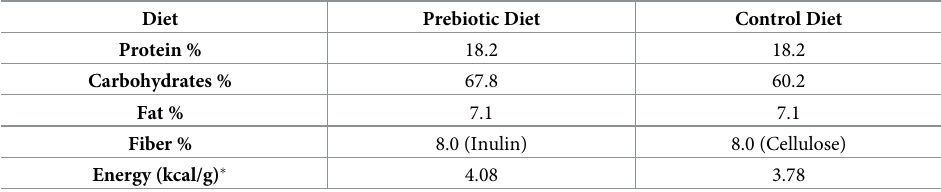
Table 1. Composition of the control and inulin